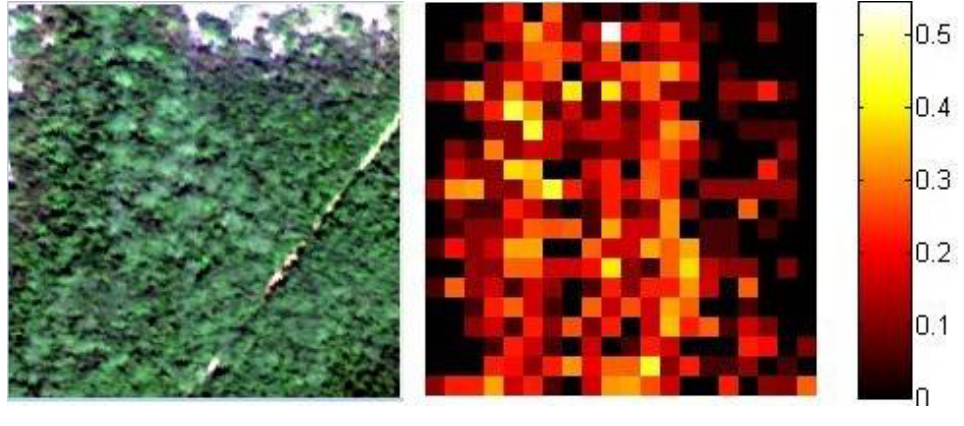
Figure 2. ( Left ) A portion of the Guanica forest, size 200 × 200 pixels; ( Right ) Computed Shannon entropies using the proposed method, zone size 10 × 10 pixels. Higher entropy means more proportional spectral